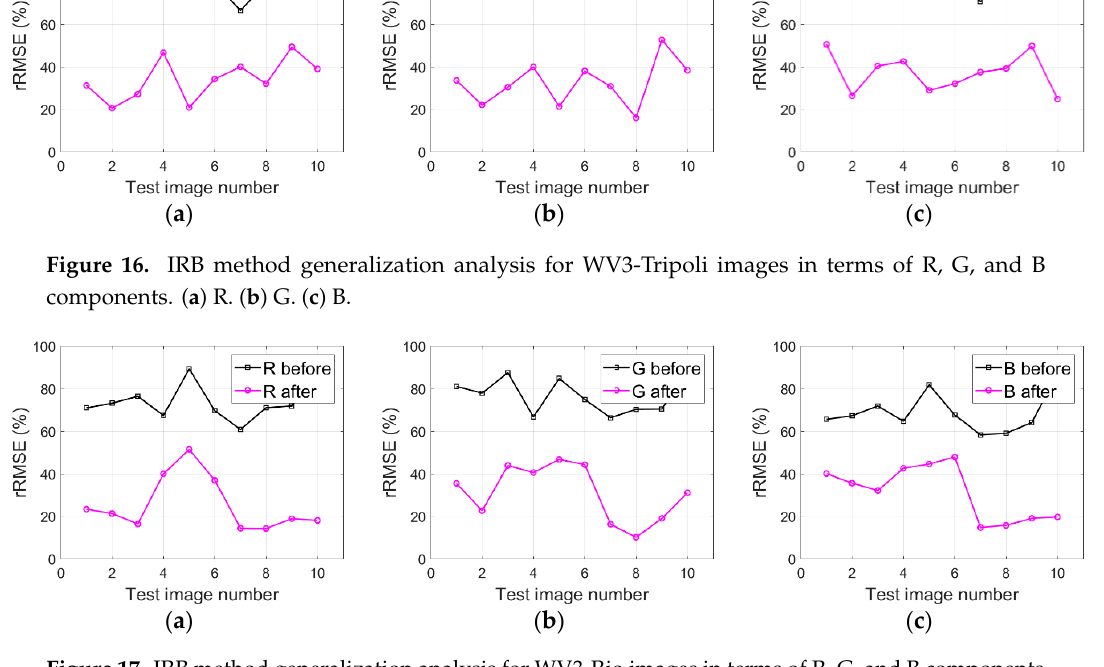
( c ) Figure 18. IRB method generalization analysis for WV2-WDC images in terms of R, G, and B components. ( a ) R. ( b ) G. ( c ) B . As can be observed in Figure 16a–c, smaller rRMSE values are achieved by the resulting WV3-Tripoli images in terms of R, G, and B components compared with the original WV3-Tripoli images. Figures 17a–c and 18a–c also show similar phenomena for WV3-Rio and WV2-WDC images, which together deliver the IRB approach and is able to well compensate shadow information for HSR multispectral satellite remote sensing images. Provided this situation, two test images of WV3-Tripoli are particularly selected in this paper to assessing the IRB approach both